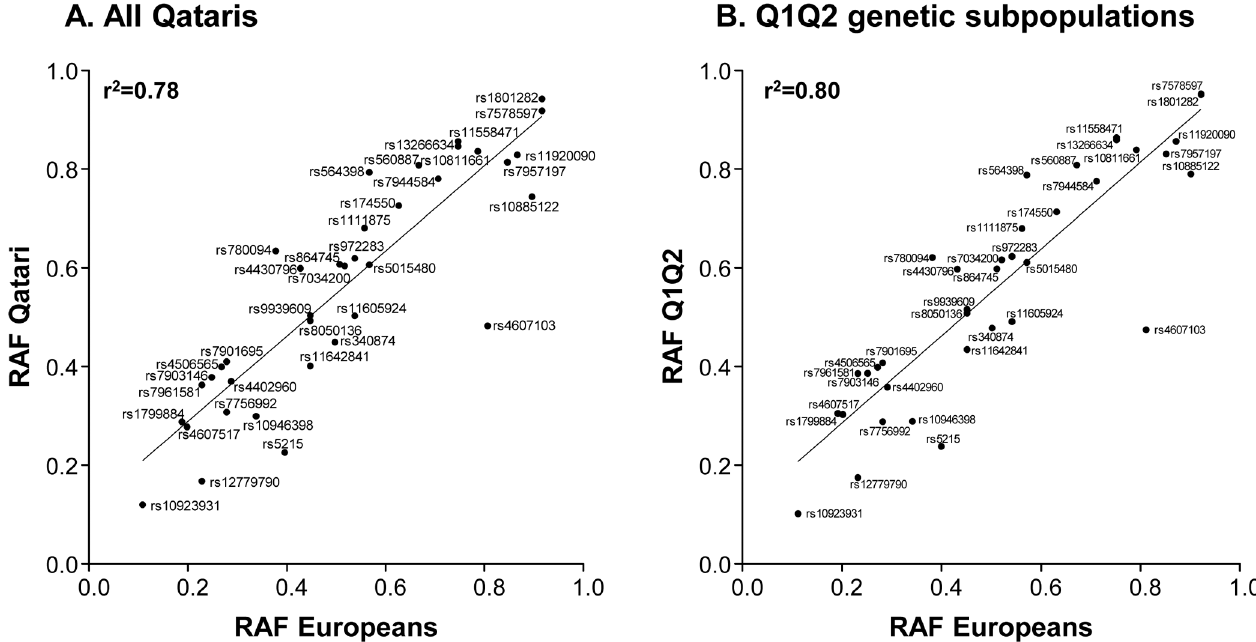
Fig 2. Population risk allele frequencies. Population risk allele frequencies (RAF) in A. all Qataris, and B. Q1 and Q2 genetic subpopulations combined, compared to European RAF (obtained from Hapmap [23]) for 37 SNPs previously associated with T2D, with the straight line indicating the regression line of best fit of the